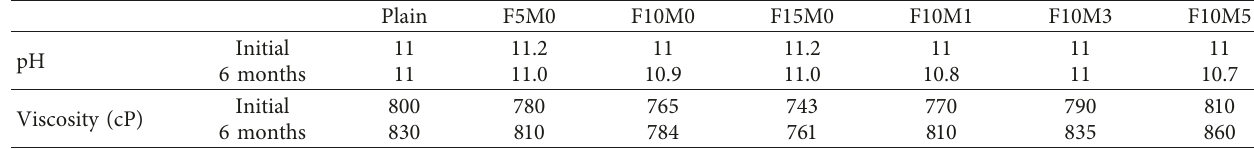
Table 10: pH and viscosity of